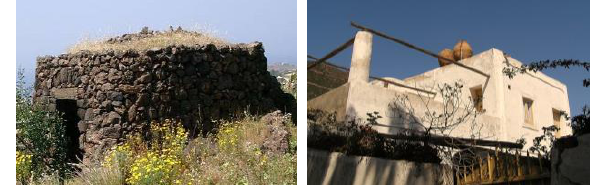
Figure 19 and 20. ‘Dammuso’ (Pantelleria, Trapani) and Rural